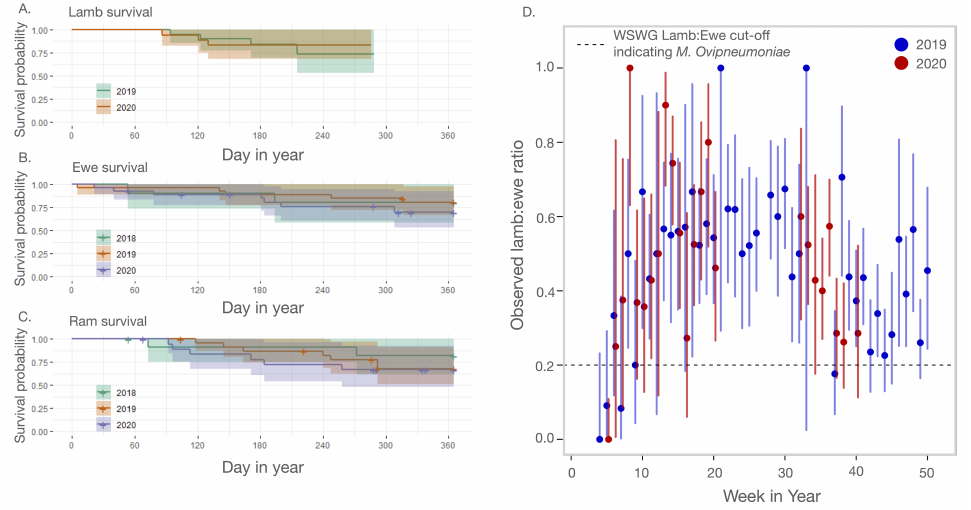
Figure 2. Animal survival throughout the outbreak. ( A – C ) Kaplan–Meier curves showing survival of lambs, ewes, and rams in the Zion population in each of the three study years. Cross-hatches indicate the dates of censoring events. Shaded regions extend to 95% confidence limits. Kaplan–Meier curves were built using the survdiff function in the survival package in R . ( D ) Weekly lamb:ewe ratios derived from field observations over the course of 2019 and 2020. Lines extend to 95% binomial confidence limits, in which the total number of trials was the total number of ewes observed over the course of the week. The dashed line shows the Wild Sheep Working Group (WSWG) cut-off for categorizing a population as experiencing problematic M. ovipneumoniae .